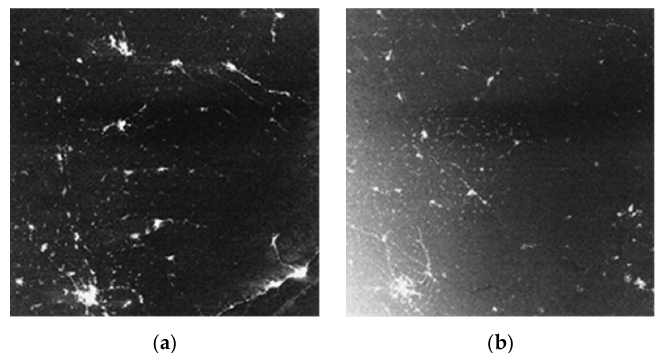
Figure 14. Different frames of night-time light image of Moscow area in one orbit. ( a ) normal image with the angle between axis and solar vector greater than 52 degree; ( b ) image effected by stray light with the angle between axis and solar vector less than 52 degree.